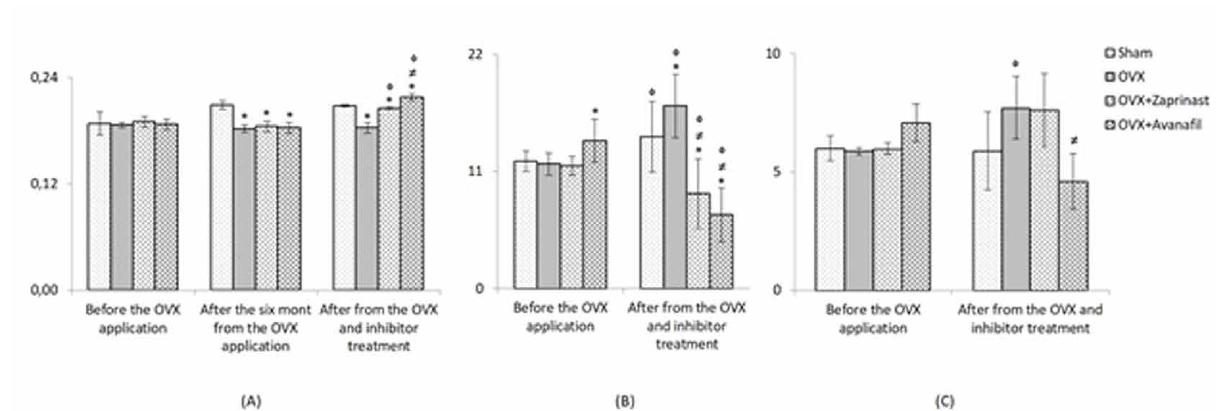
FIGURE 1 – Comparison of bone mineral density and urine pyridinoline and deoxypyridinoline levels before and after the OVX and inhibitor application. (A): Radiological measurement of bone mineral density (g/cm 2 ). (B): Urine pyridinoline levels (nmol/ mL). (C): Urine deoxypyridinoline levels (nmol/mL). * p<0.05: compared to the control gorup, ≠ p<0.05: According to the